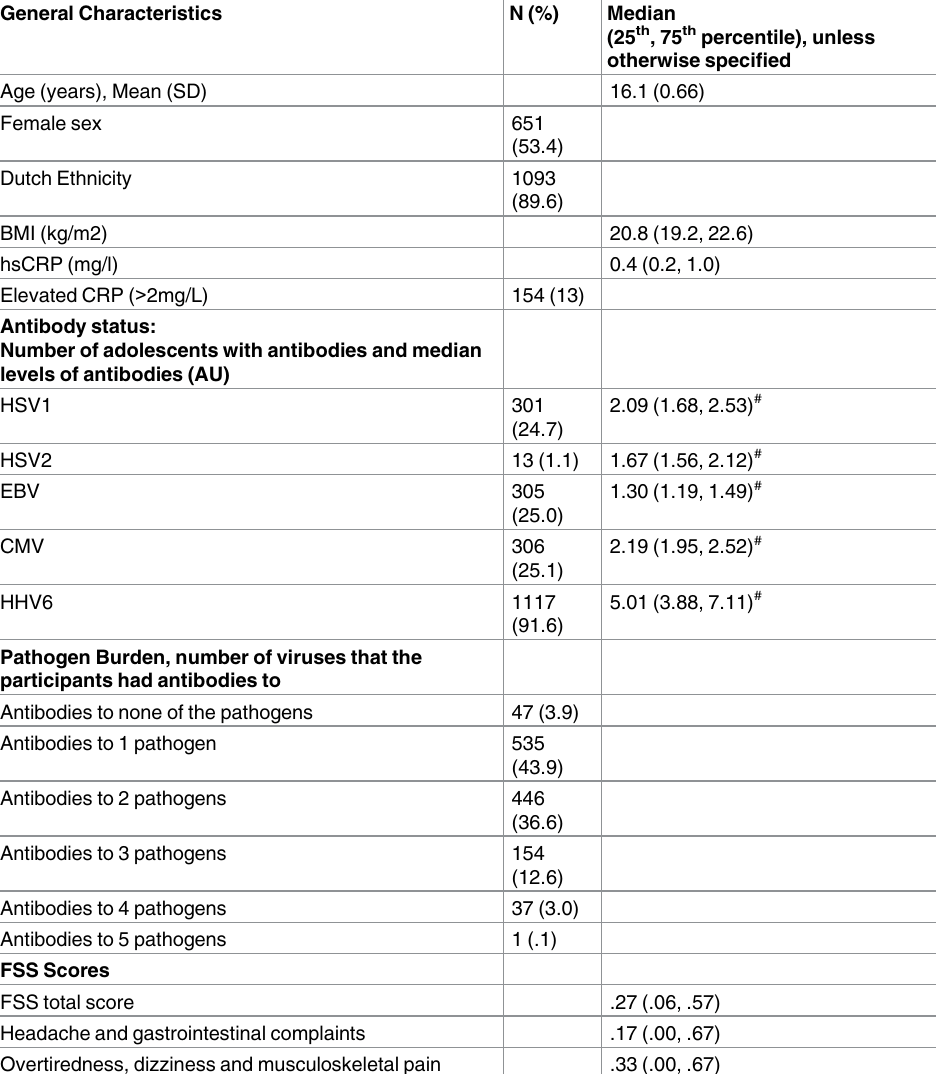
Table 1. Population characteristics. General